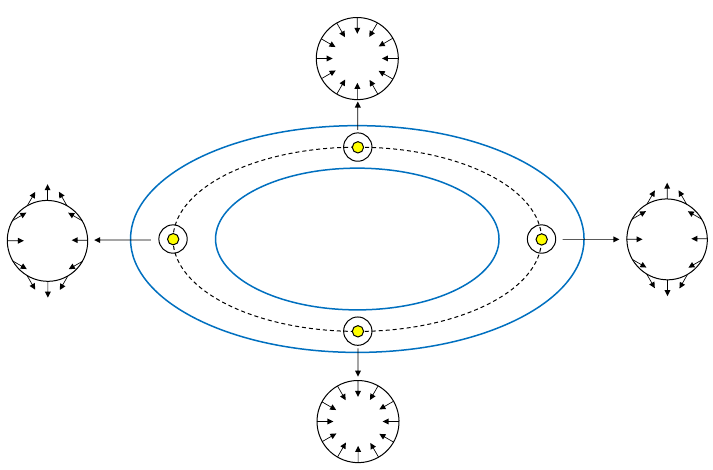
Figure 13 . Two homogeneously negatively charged coplanar circles which have been stretched to ellipses. On the ellipse which is equidistant to the two charge loci, the electric (cid:12)eld only vanishes at the four points marked as black dots. To (cid:12)nd the Morse index, consider the small circles (coplanar to the ellipses) around these points and the restriction of the electric (cid:12)eld to these circles. The Morse index of the points near the vertices of the ellipse is 2 and while those near the co-vertices have a Morse index of 1. As before, the critical loci are shown in yellow, and the charges in